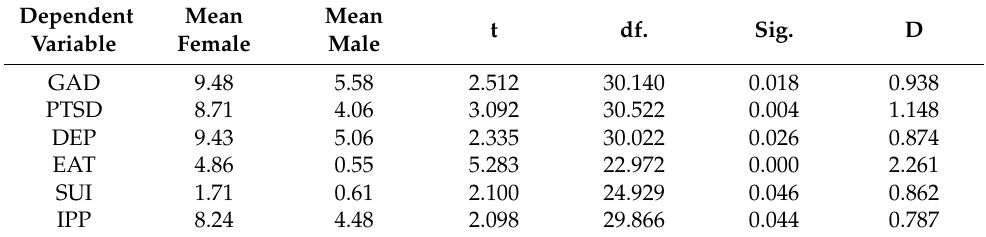
Table 4. Significant results for female vs. male (adolescents with diabetes).